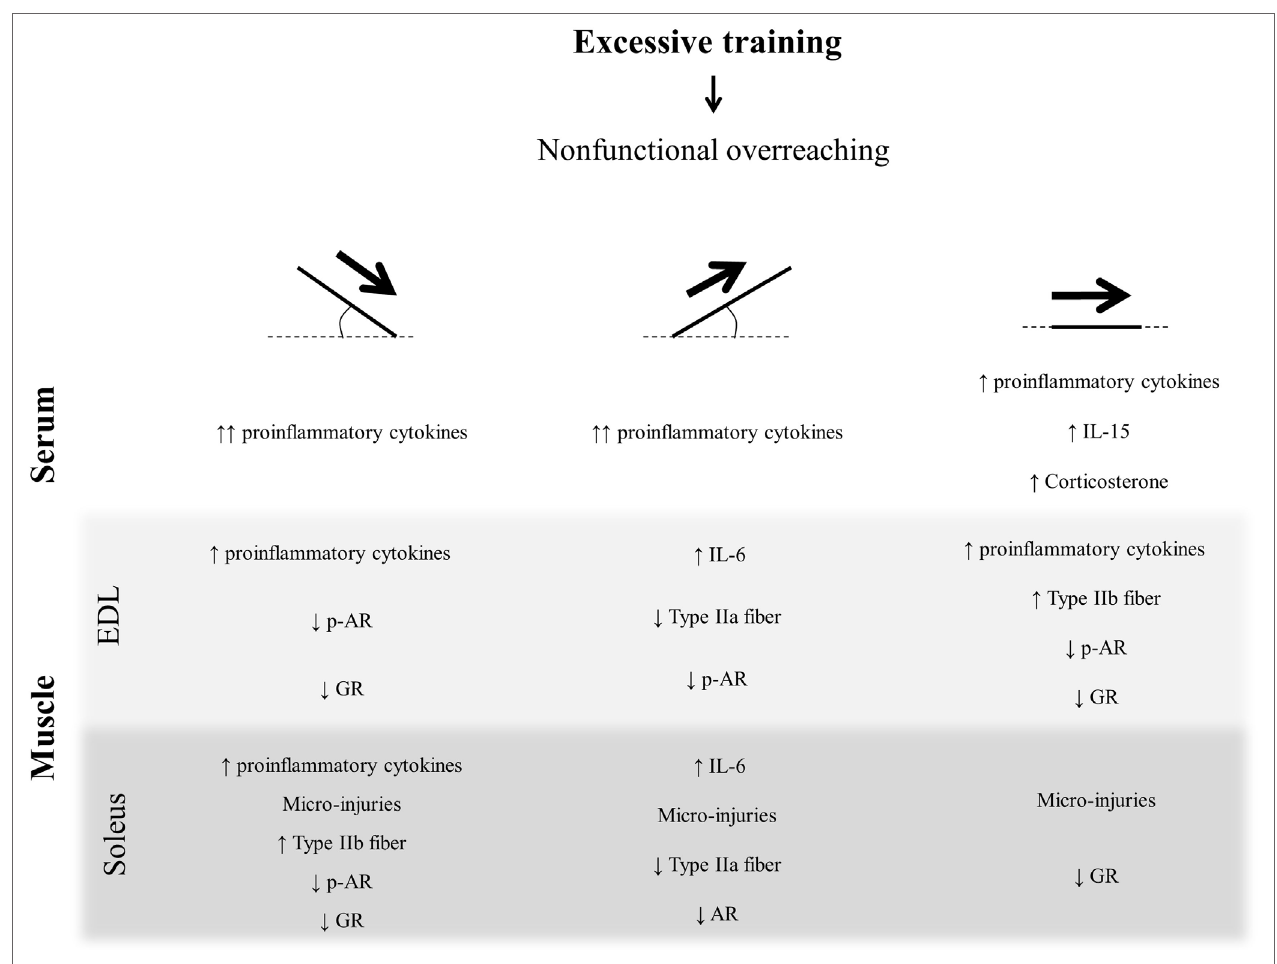
FigUre 8 | Schematic model summarizing the present